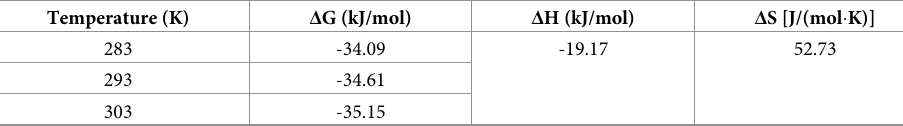
Table 7. Apparent thermodynamic parameters of AFB1 adsorption in